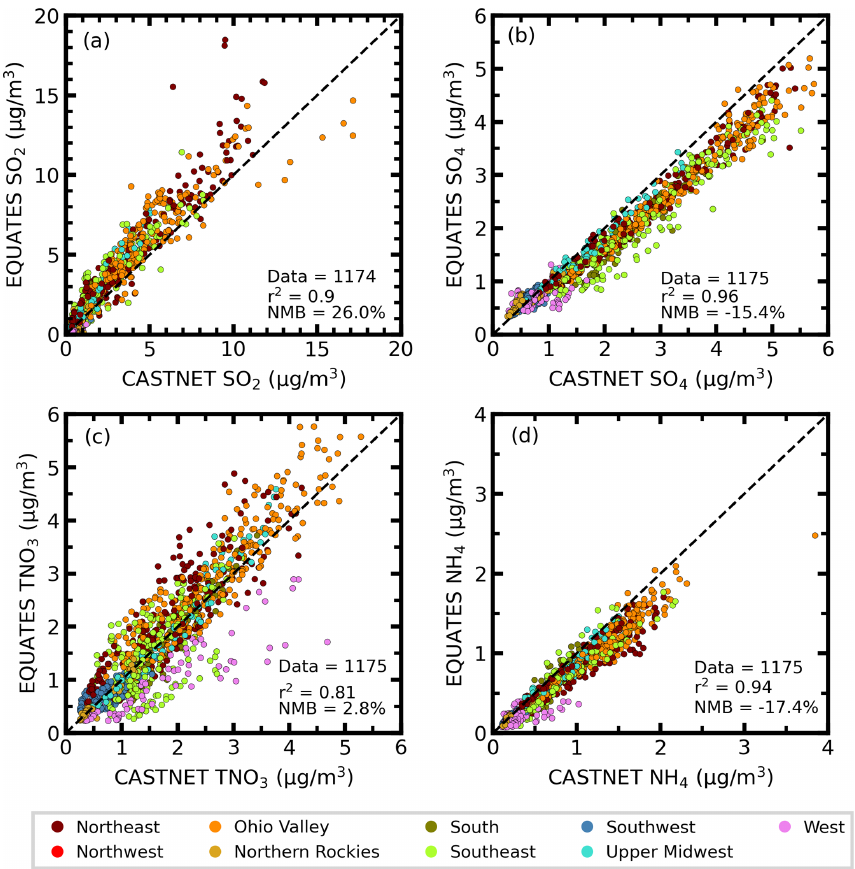
Figure 4. Scatterplots comparing 2002–2017 annual average concentrations (µgm − 3 ) of sulfur dioxide ( a , SO 2 ), sulfate ( b , SO 4 ), total nitrate ( c , TNO 3 ), and ammonium ( d , NH 4 ) between EQUATES output and CASTNET observations ( N = 1175). The marker color corre- sponds to the climate region. Data from CASTNET sites with at least 75% valid data available for each of the 13 years analyzed are included in the analysis